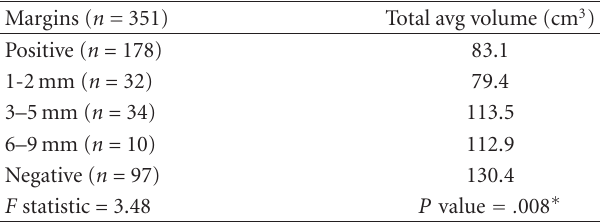
Table 4: Volume of excision relative to the margin